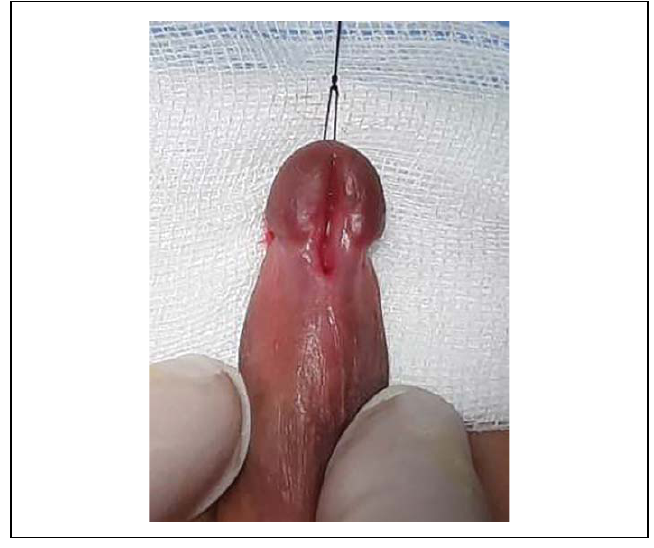
Figure 1. Circumcised Megameatus intact